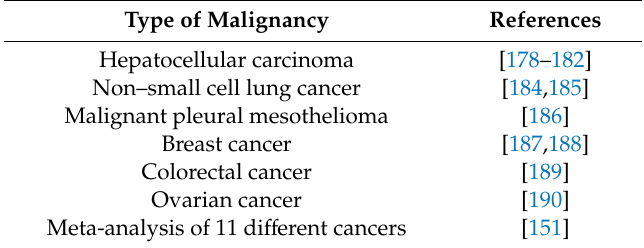
Table 3. Human cancers in which HMGB1 has been implicated in disease